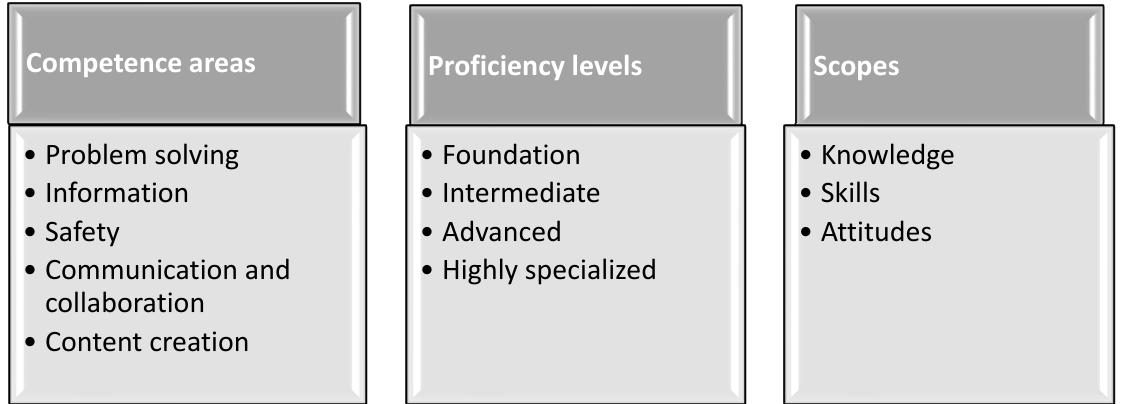
Figure 1. DigCom Framework 2.1. Own elaboration. Table 3. Competence areas and competences of the DigCom 2.1. framework. Source Carretero et al. [62].